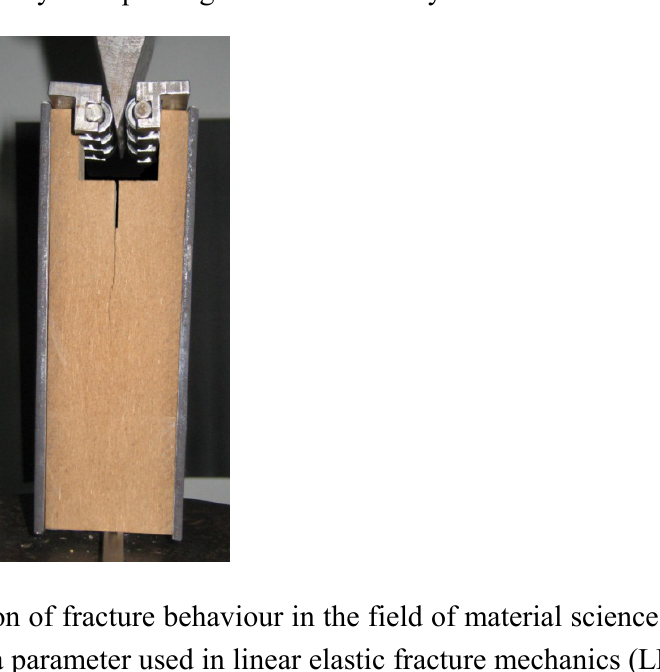
Figure 1. Wedge splitting test setup for the core layer testing of medium density fiber board (MDF). Specimen is reinforced by steel plates glued to the face layers of